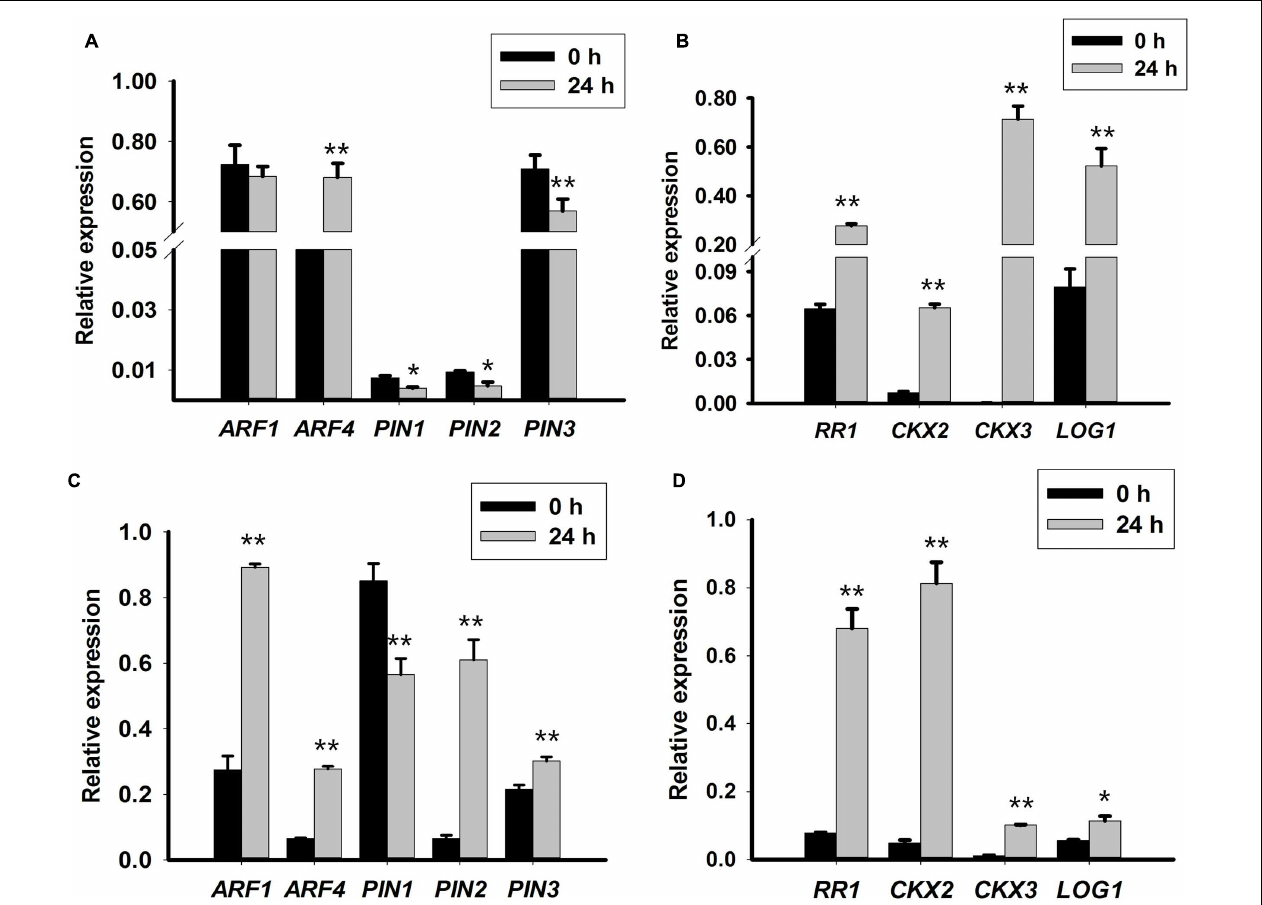
FIGURE 3 | Expression levels of auxin- and cytokinin-related genes in callus-rhizoids or rhizoid tips. Callus-rhizoids (0.1–0.2 g fresh) or rhizoids only were collected after culture on PIM for 0 or 24 h. Quantitative real-time PCR was used to analyze genes expression levels. (A,B) Gene expression in callus-rhizoids. (C,D) Gene expression in rhizoid tips. Error bars represent the SE of three biological replicates. Error bars represent the SE of three biological replicates. Asterisks indicate significant ( ∗ P < 0.05) or highly significant ( ∗∗ P < 0.01) differences calculated using the t -test ( n = 3 for each treatment).